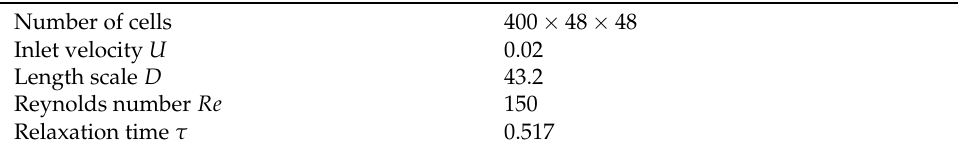
Table 2. Numerical conditions of pipe flow